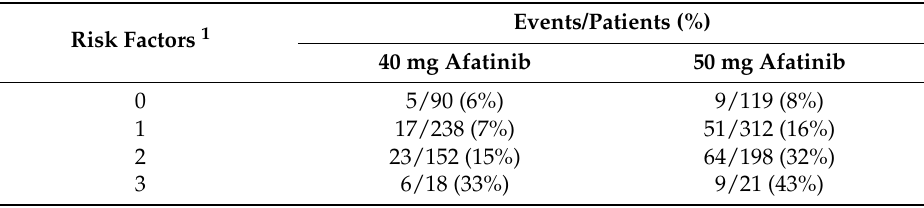
Table 3. Risk of grade ≥ 3 diarrhea with afatinib treatment (40 mg or 50 mg starting dose) by count of risk factors 1